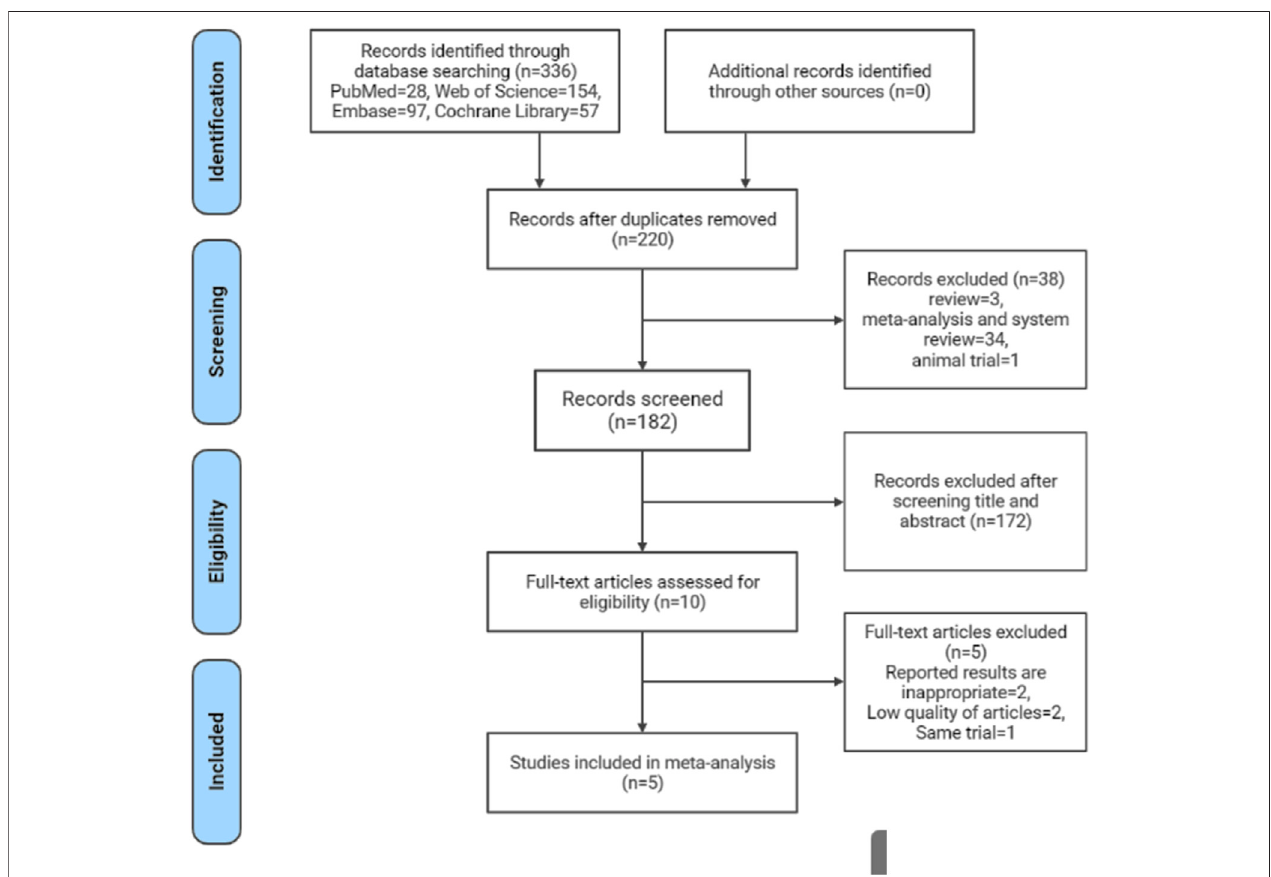
FIGURE 1 | Flowchart of study selection in this systematic review and meta-analysis.